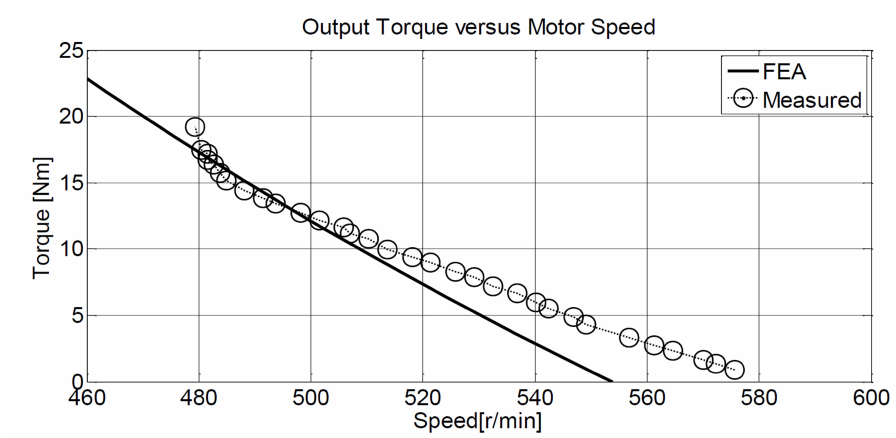
Figure 14. Output torque versus motor